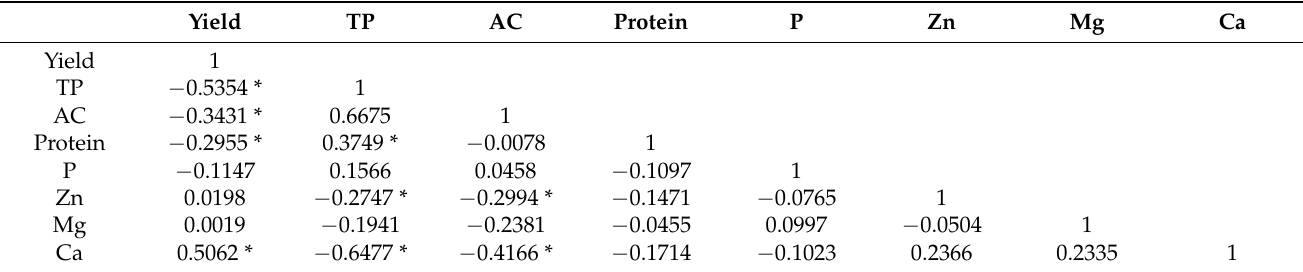
Figure 4. Principal component analysis (PCA) on covariance of nutraceutical properties of Venetian bean ( P. vulgaris ) local varieties cultivated in a rain-out shelter between March and August 2020. Table 4. Correlations coefficients of the variables of Venetian bean ( P. vulgaris ) local varieties cultivated in a rain-out shelter between March and August 2020, estimated by the restricted maximum likelihood (REML) method.